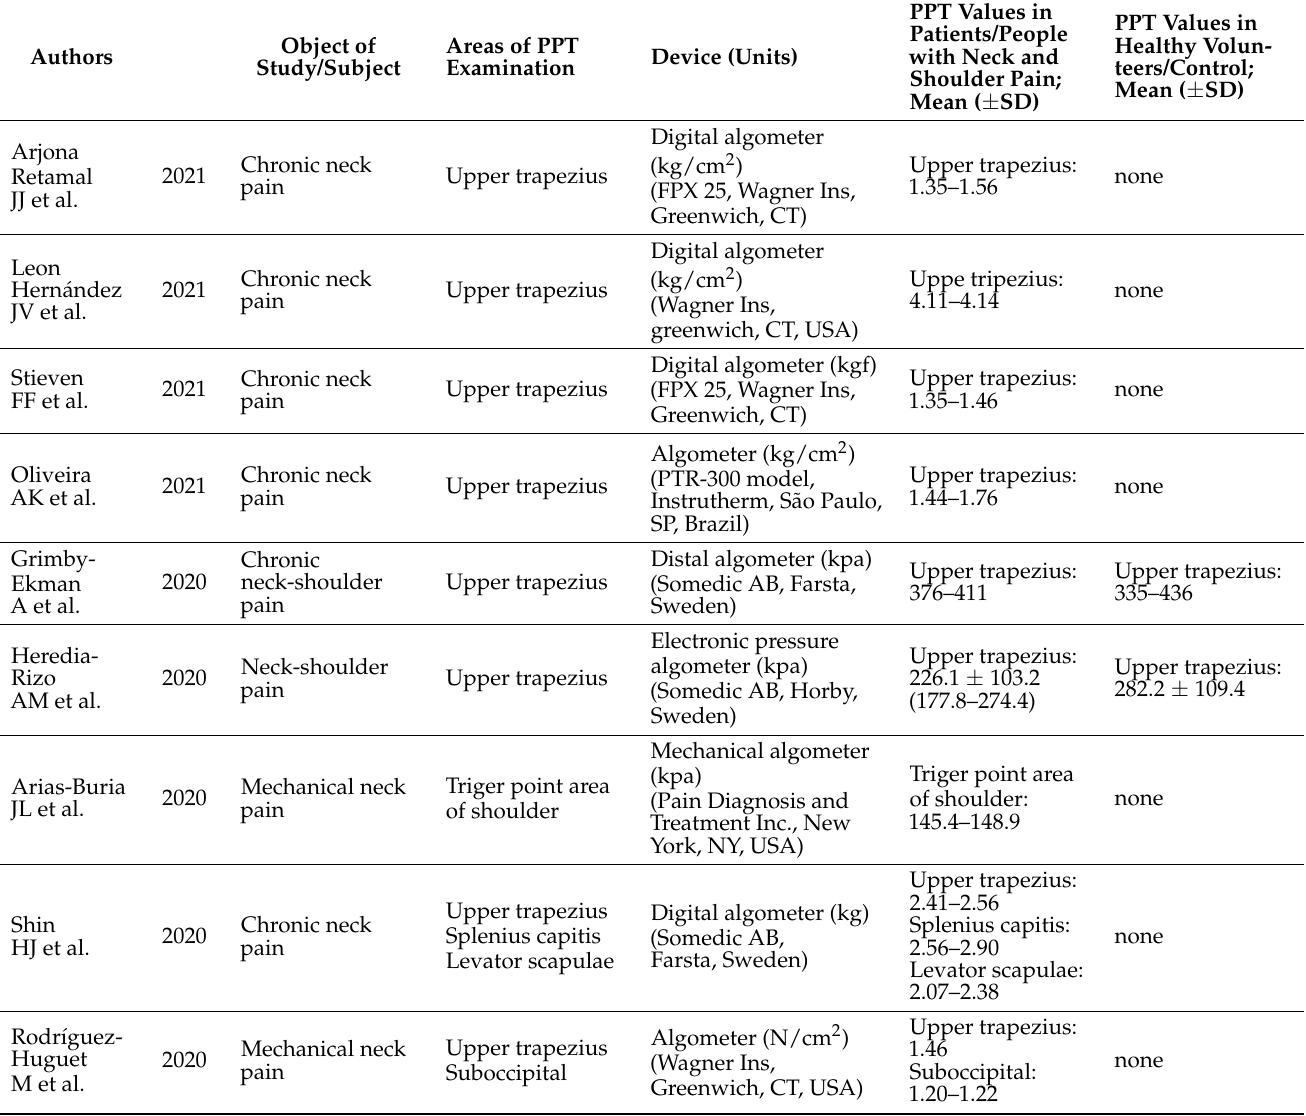
Table 2. Pressure Pain Threshold (PPT) Values of Neck and Shoulder in Volunteers/Patients with and without Neck/shoulder